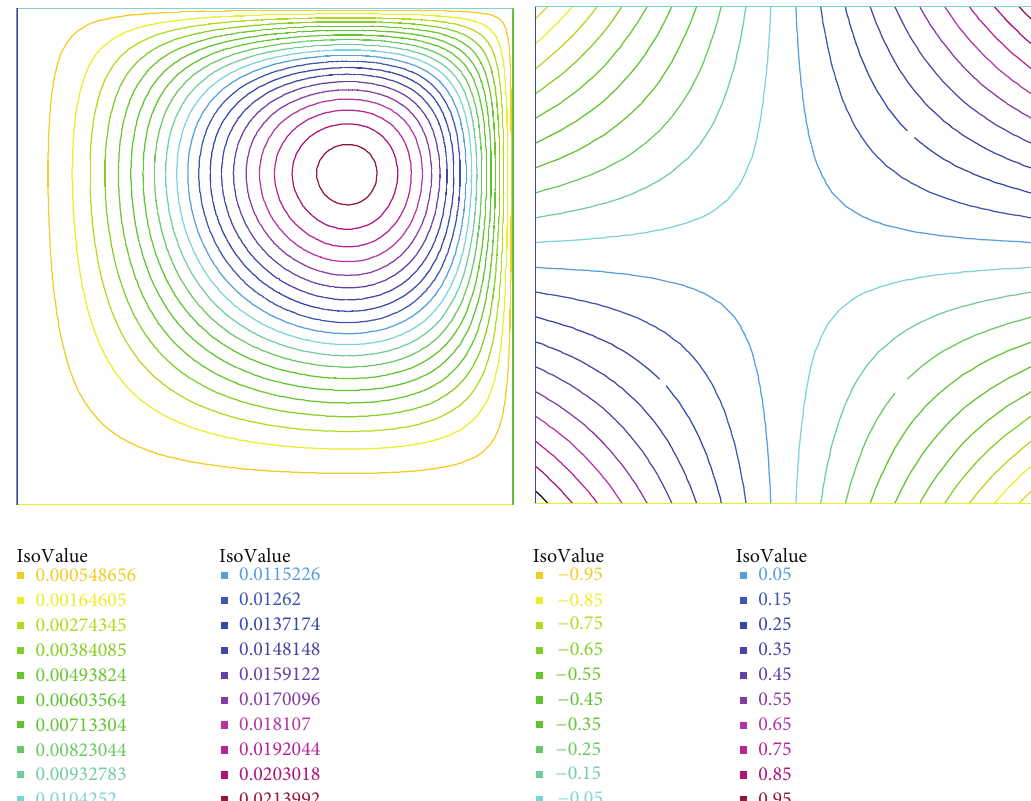
Figure 2: Streamline of flow and pressure contour for exact